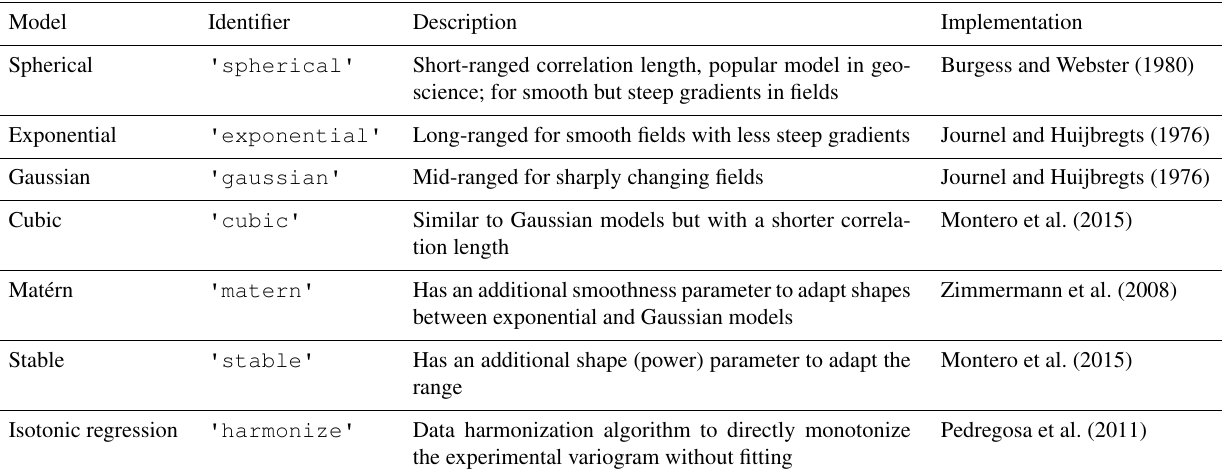
Table 2. Overview of all theoretical variogram model functions implemented in